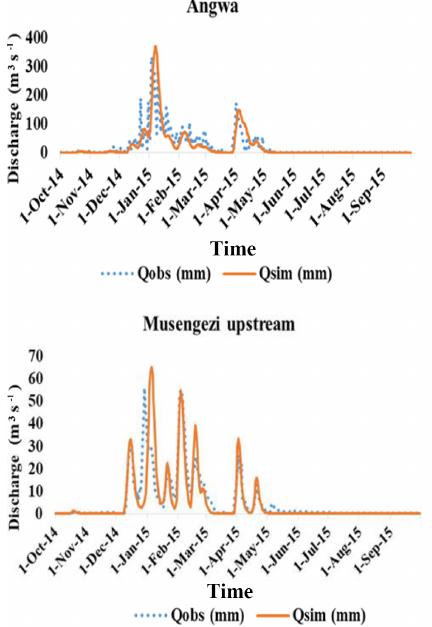
Figure 3. Calibration results for Angwa and Musengezi rivers up- stream based on daily